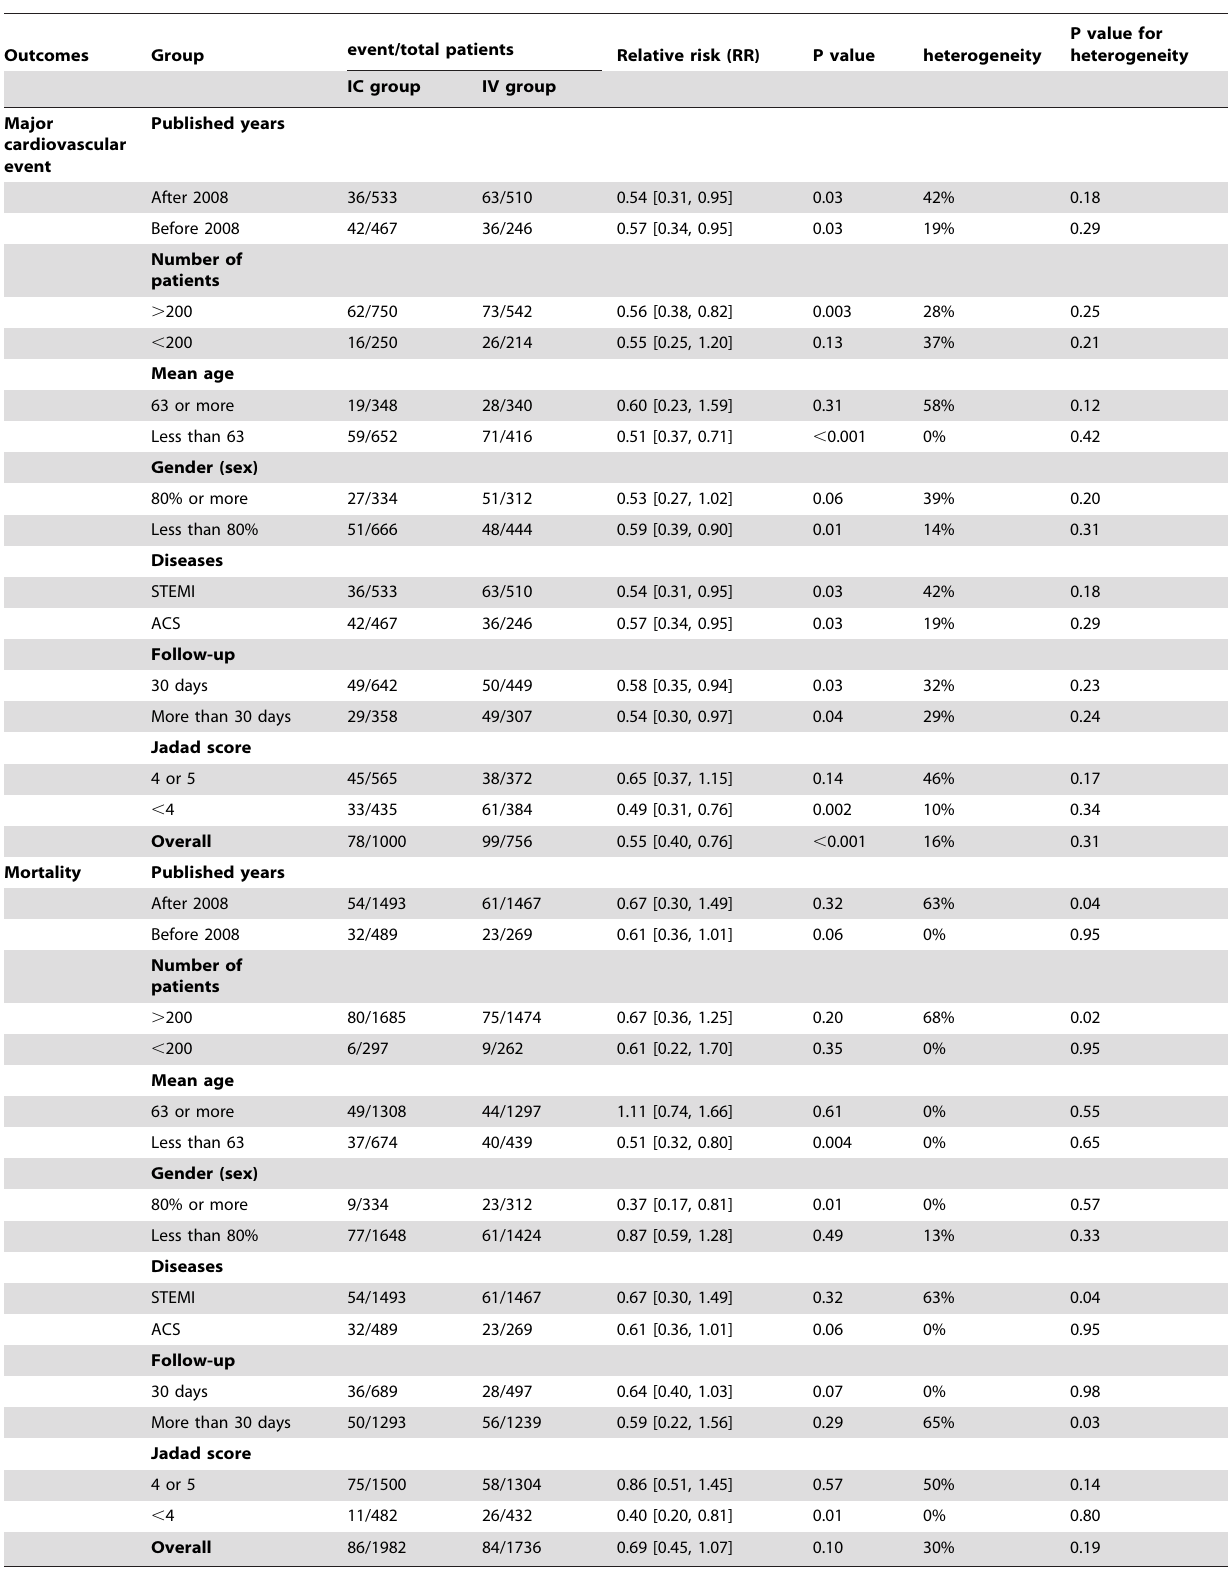
Table 3. Subgroup analysis for the effect of IC versus IV therapy on major cardiovascular events, and mortality.